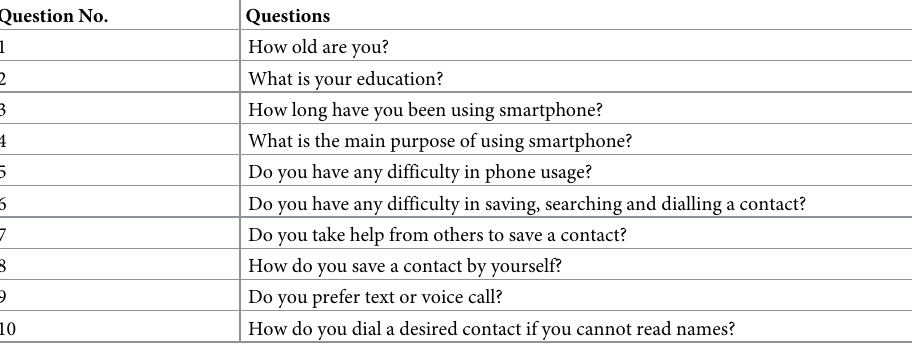
Table 2. Questions explored during each interview